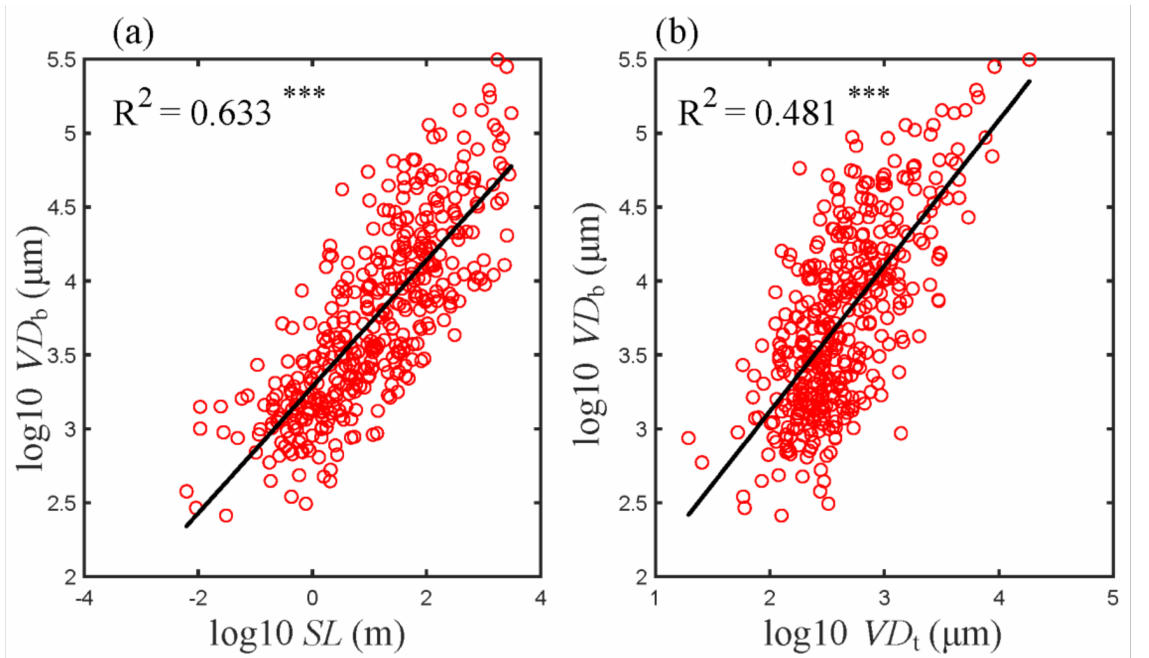
Figure 1. Log − log scaling relationships between VD b and SL ( a ) and VD t ( b ). R 2 is indicated in each panel. Asterisks indicate levels of significance (*** p < 0.001). Abbreviations for traits are the same as in Table 1.